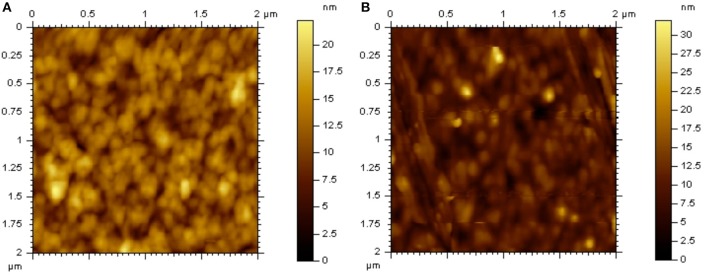
AFM images of (A) DTRDTQX:C70(1:2) and (B) DTIDTQX:C70(1:2) films.